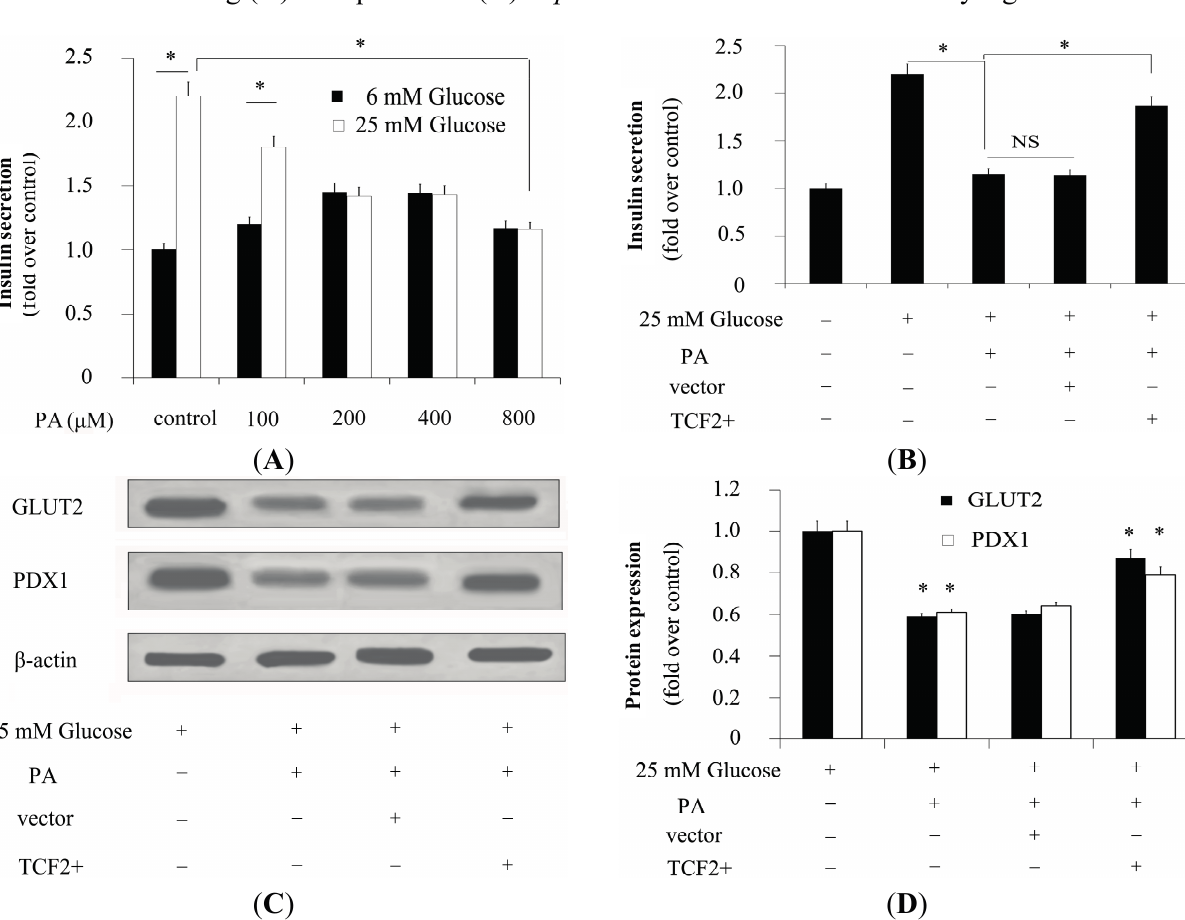
Figure 4. INS-1 cells were cultured in DMEM with 6 mM or 25 mM glucose